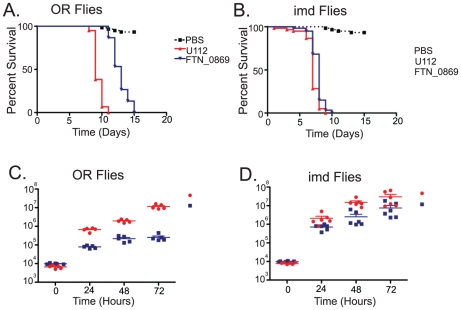

F. novicida deletion mutants of a putative transglutaminase are severely attenuated in virulence and growth.(A) Survival of wild-type and FTN_0869 mutant bacteria in wild-type flies at 25°C. FTN_0869 mutants demonstrate significantly lower survival compared to wild-type F. novicida with a P value by log-rank analysis of <0.0001. The MTD for U112 is 9 days at 25°C, while the MTD for FTN_0869 is 12 days post infection, with a P value by log-rank analysis of <0.0001. (B) Survival of wild-type and FTN_0869 mutant bacteria in imd mutant flies at 25°C. The FTN_0869 phenotype is now partially rescued as the FTN_0869 mutant and wild-type Francisella die with MTDs of 7 and 8 days respectively at 25°C, a 4-fold decrease in the spread between mutant and wild-type survival. (C) Total wild type and FTN_0869 mutant growth in wild type OR flies, showing a growth defect of FTN_0869 mutants. At each timepoint, U112 and the FTN_0869 mutants are significantly different with P values from a 2-tailed t-test of <0.0001. At 24 hours post-infection, U112 has 8.5-fold more CFU/fly than the FTN_0869 mutant. At 48 hours, U112 has 8.9-fold more bacteria, and at 72 hours, U112 infected flies have a full 45-fold more bacteria than the FTN_0869 mutant, with a difference between mutant and wild-type of 5.9*105 at 24 hours, 1.7*106 at 48 hours, and 1.1*107 at 48 hours. Horizontal lines represent the mean CFU/fly at each timepoint. Error bars represent standard error. (D) Growth of wild-type and FTN_0869 mutant bacteria in imd mutant flies, showing rescue of the growth defect. The difference between the mean number of CFUs of wild-type and FTN_0869 has decreased at every timepoint, with only a 2.9-fold increase in wild-type bacteria compared to FTN_0869 bacteria at 24 hours, 6-fold more bacteria in U112 infected flies at 48 hours, and only 4-fold more U112 bacteria than FTN_0869 bacteria at 72 hours. Horizontal lines represent the mean CFU/fly at each timepoint. Error bars represent standard error.